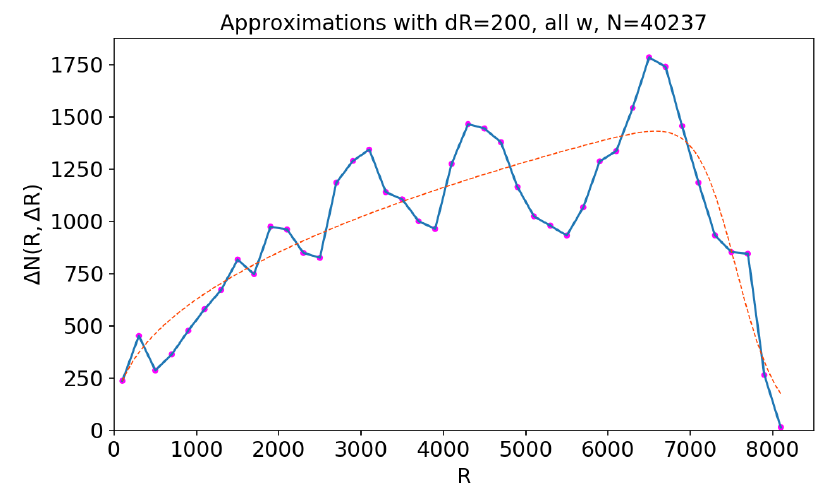
Figure A3. Histogram of radial distribution of the Deep-UltraVISTA [6] photometric redshifts recalculated to metric distances in comoving space with a bin ∆ R = 200 Mpc without sampling by σ ( z ) . The dashed line indicates the least-squares fit by the theoretical approximation of homogeneity (according to the SCM) by Equation